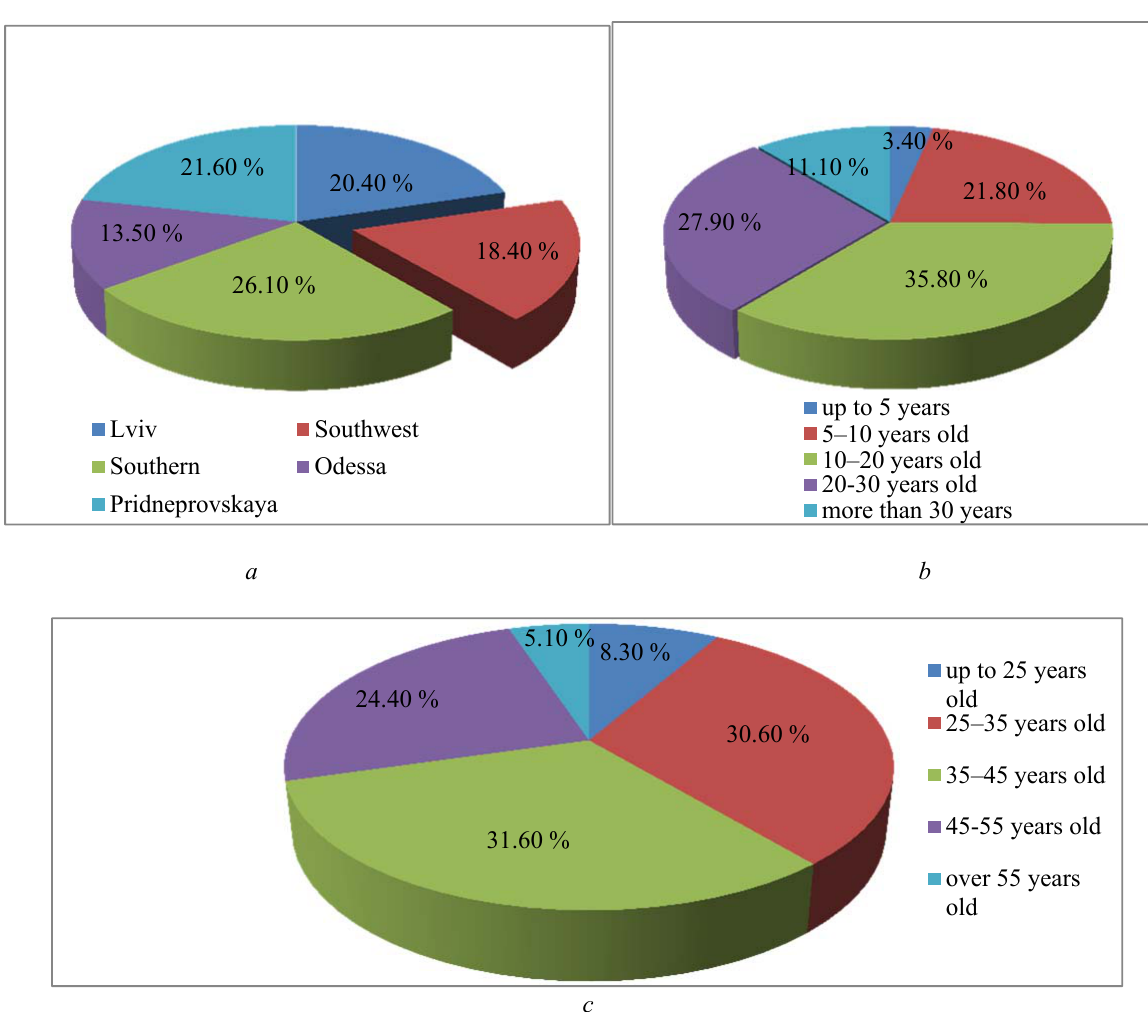
Fig. 3. Respondents who participated in a study concerning the provision of medical kits trains: a – by regions; b – by experience: c – by